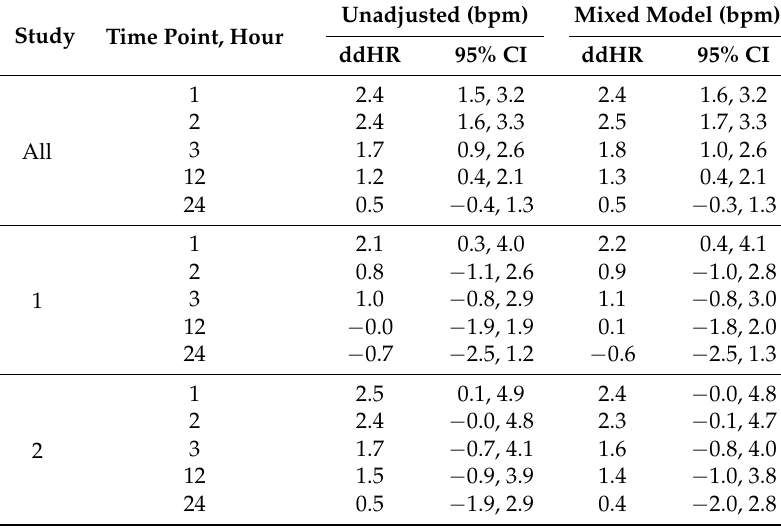
Table 2. ddHR by study and time